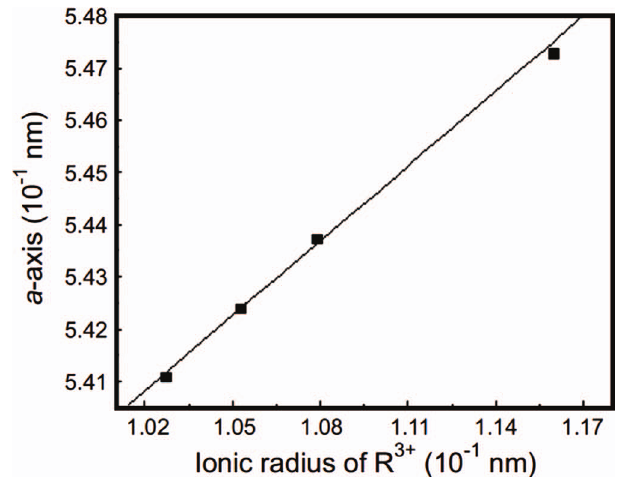
Fig. 6. LaDC, SDC, GDC, and GYDC lattice parameters plotted against R 3+ ionic radius.